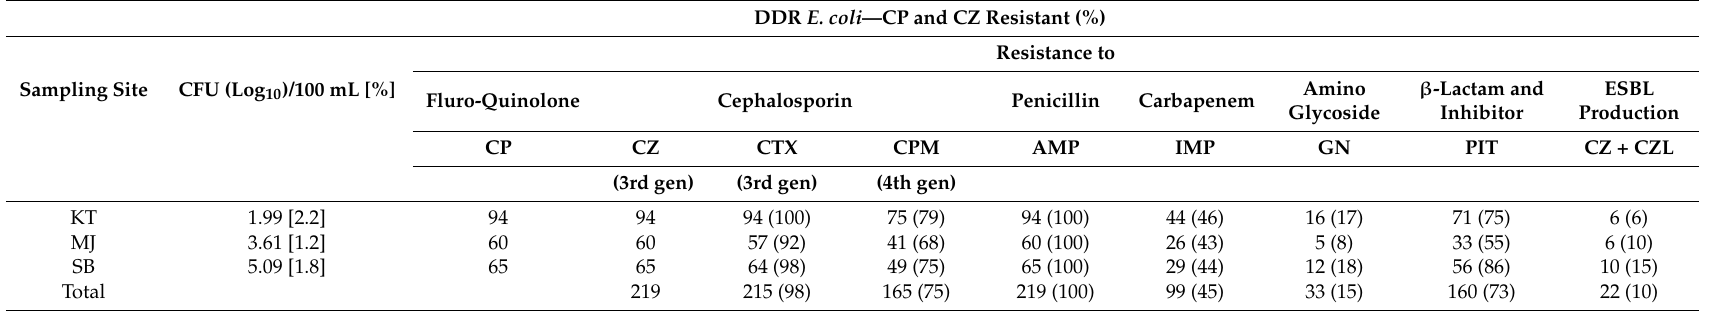
Table 2. Dual drug-resistant (DDR) E. coli load at different sites and their antibiotic resistance profile. DDR E. coli —CP and CZ Resistant (%) Sampling